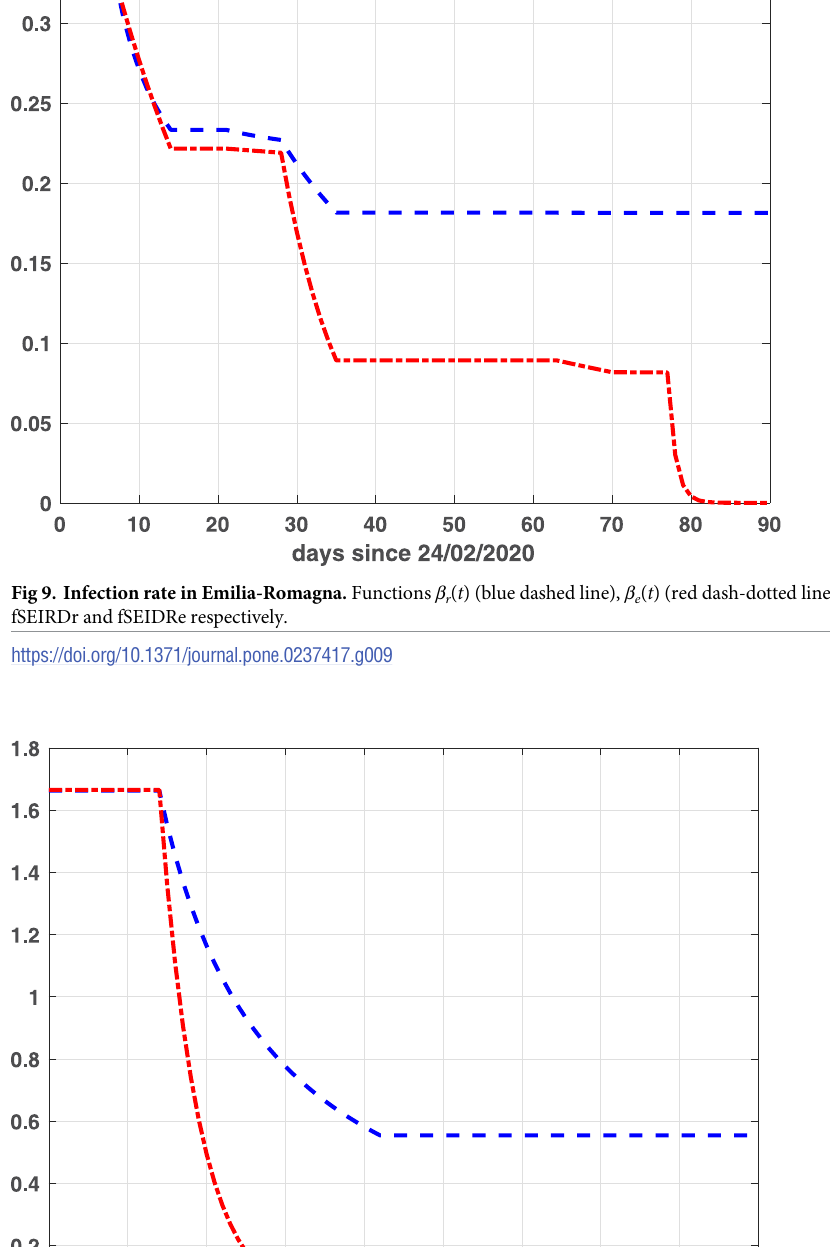
( t ) (blue dashed line), β ( t ) (red dash-dotted line), r e